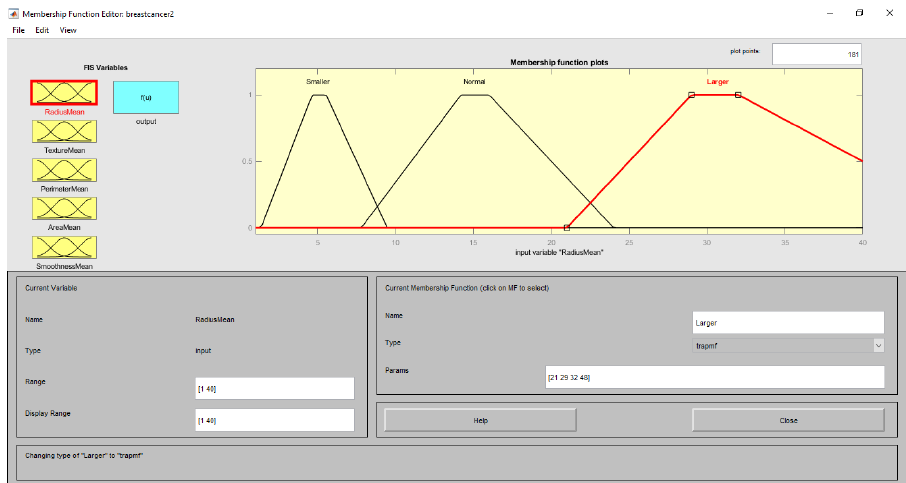
Figure 14. Membership functions of the linguistic variables of the radius mean input.